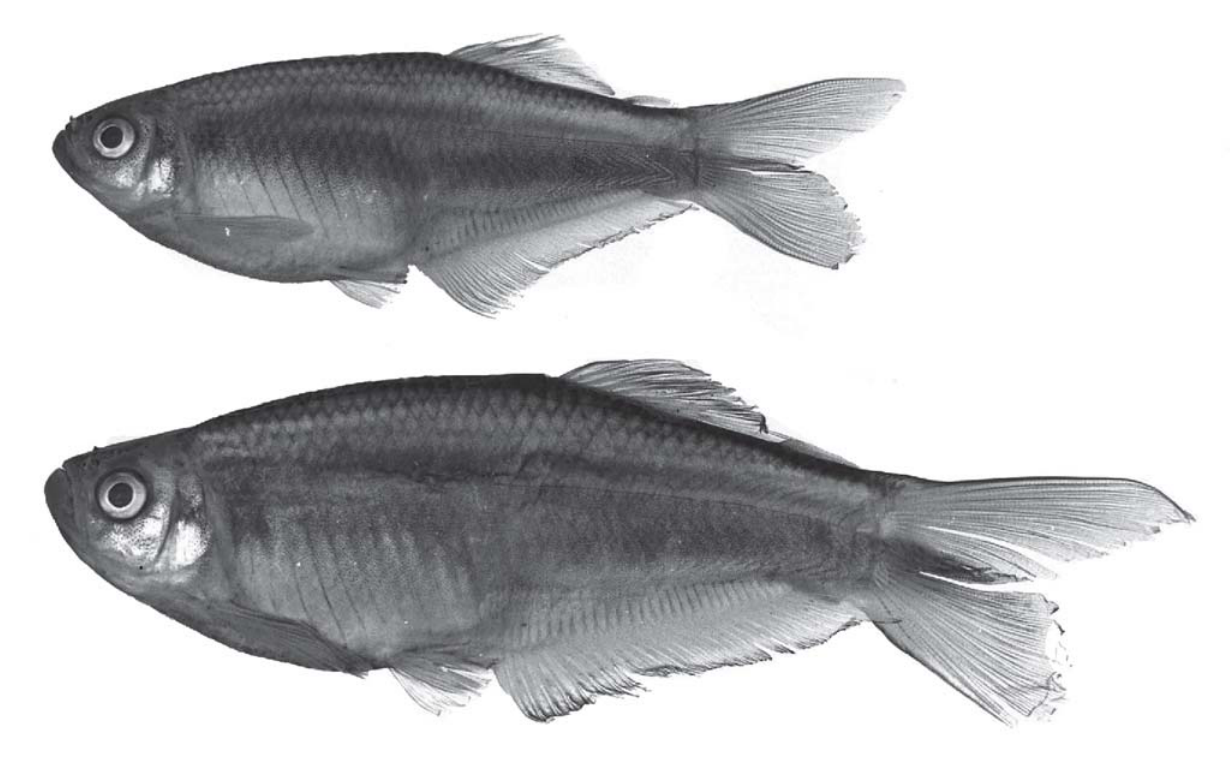
Fig. 77. Mimagoniates microlepis , young adults male below, female above, USNM 254261, 61.2.0 mm and 43.0 mm SL, respectively, Brazil, São Paulo State, rio Silva on road between Ubatuba and